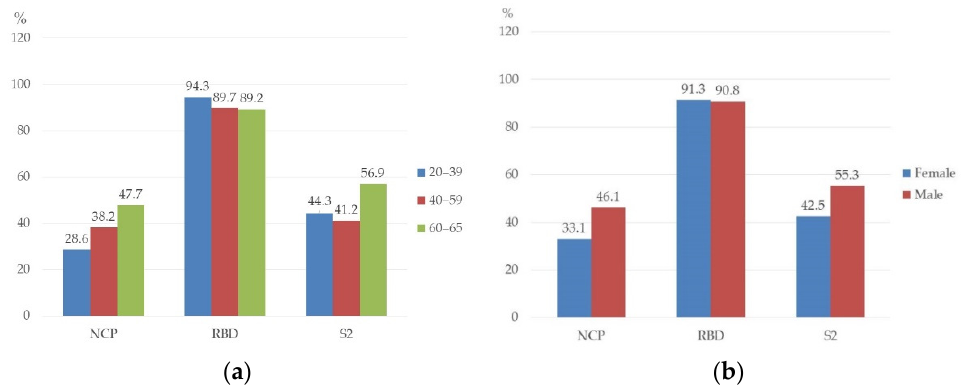
Figure 1. Prevalence of antibodies against SARS-CoV-2 in healthcare workers by age ( a ) and sex ( b ) (%); all groups p > 0.05. Table 2. Prevalence of NCP, RBD, and S2 antibodies in the studied